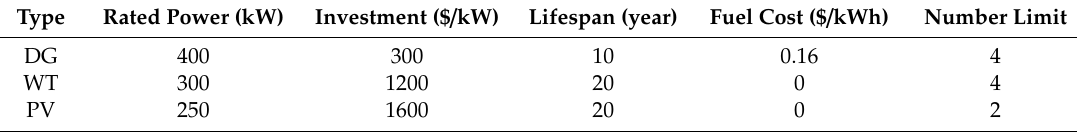
Figure 4. Structure of the IEEE 33-bus distribution system based MG. Table 1. Technical Parameters of DERs.